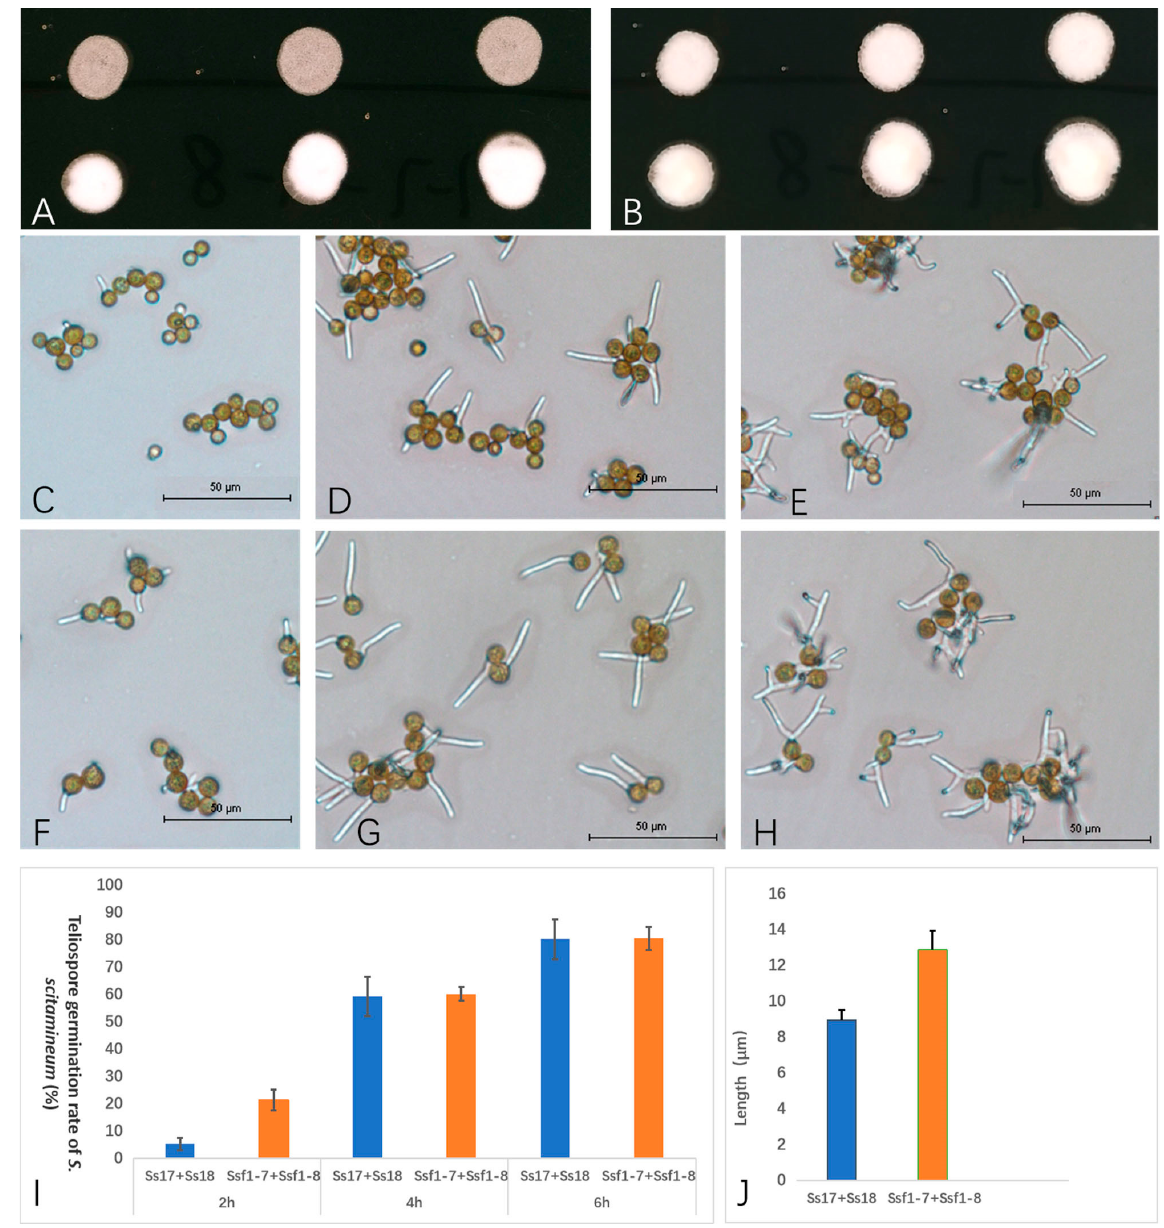
Figure 2. Mating ability and teliospore germination of two different strains of S. scitamineum . Mating assay for 24 h ( A ) and 48 h ( B ) respectively. Upper line are mixed cells of Ss17 + Ss18, and lower line are mixed cells of Ssf1-7 +Ssf1-8; ( C – E ): Teliospores germination of Ss17 + Ss18 at 2, 4 and 6 h, respec- tively; ( F – H ): Teliospores germination of Ssf1-7 +Ssf1-8 at 2, 4 and 6 h, respectively; ( I ): Teliospore germination rates of different isolates of S. scitamineum and ( J ): Length of basidia produced from teliospores of S. scitamineum in 4 h. Significant difference ( p < 0.05) determined by Student’s t -test. 2.2. Pathogenicity of Smut Fungus Isolated from Sugarcane Inflorescence To assess the virulence of the Ssf1-7 and Ssf1-8 isolates, we inoculated their 1:1 mixed cells to disease-free tissue- cultured seedlings of six commercial sugarcane varieties, namely GT42, GT44, GT49, GT55, LC05-136 and